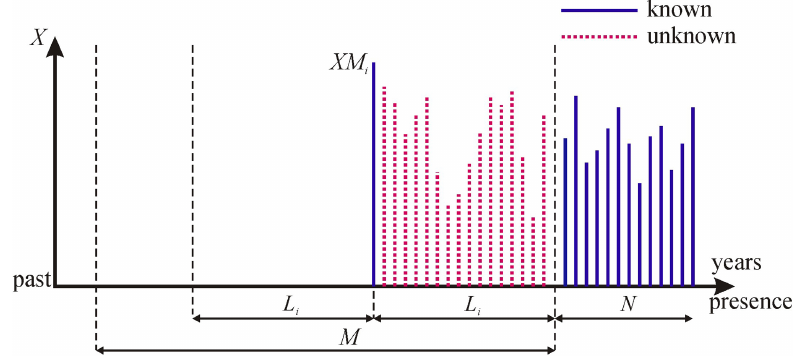
Figure 1. The case of N systematic and the largest flood in the beginning of historical